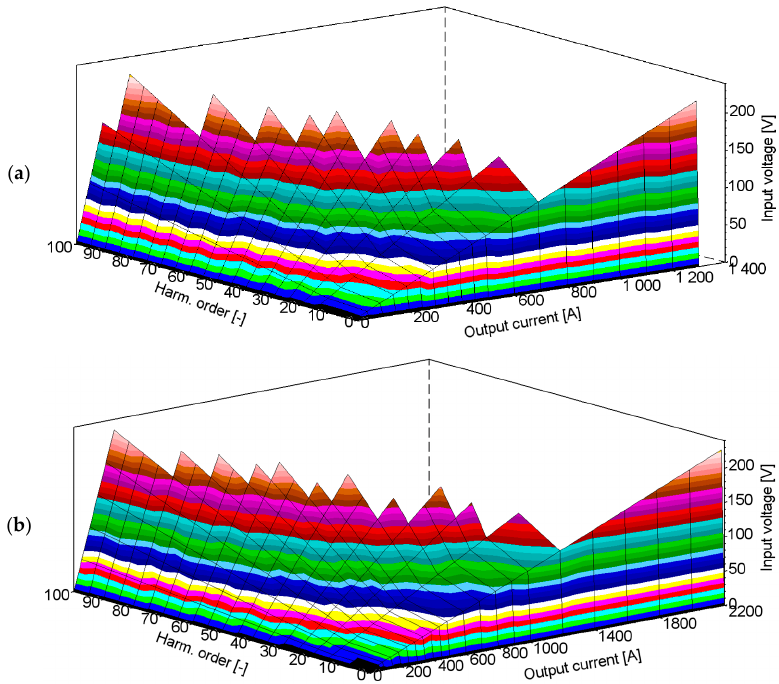
Figure 4. The measured distorted output current with a given harmonic order for supplied primary voltage obtained for serial connection of the primary winding’s sections and parallel connection of the secondary winding’s sections: ( a ) R L = 0.3 m Ω ; L L = 3 μ H, ( b ) R L = 0.2 m Ω ; L L = 1.5 μ H.